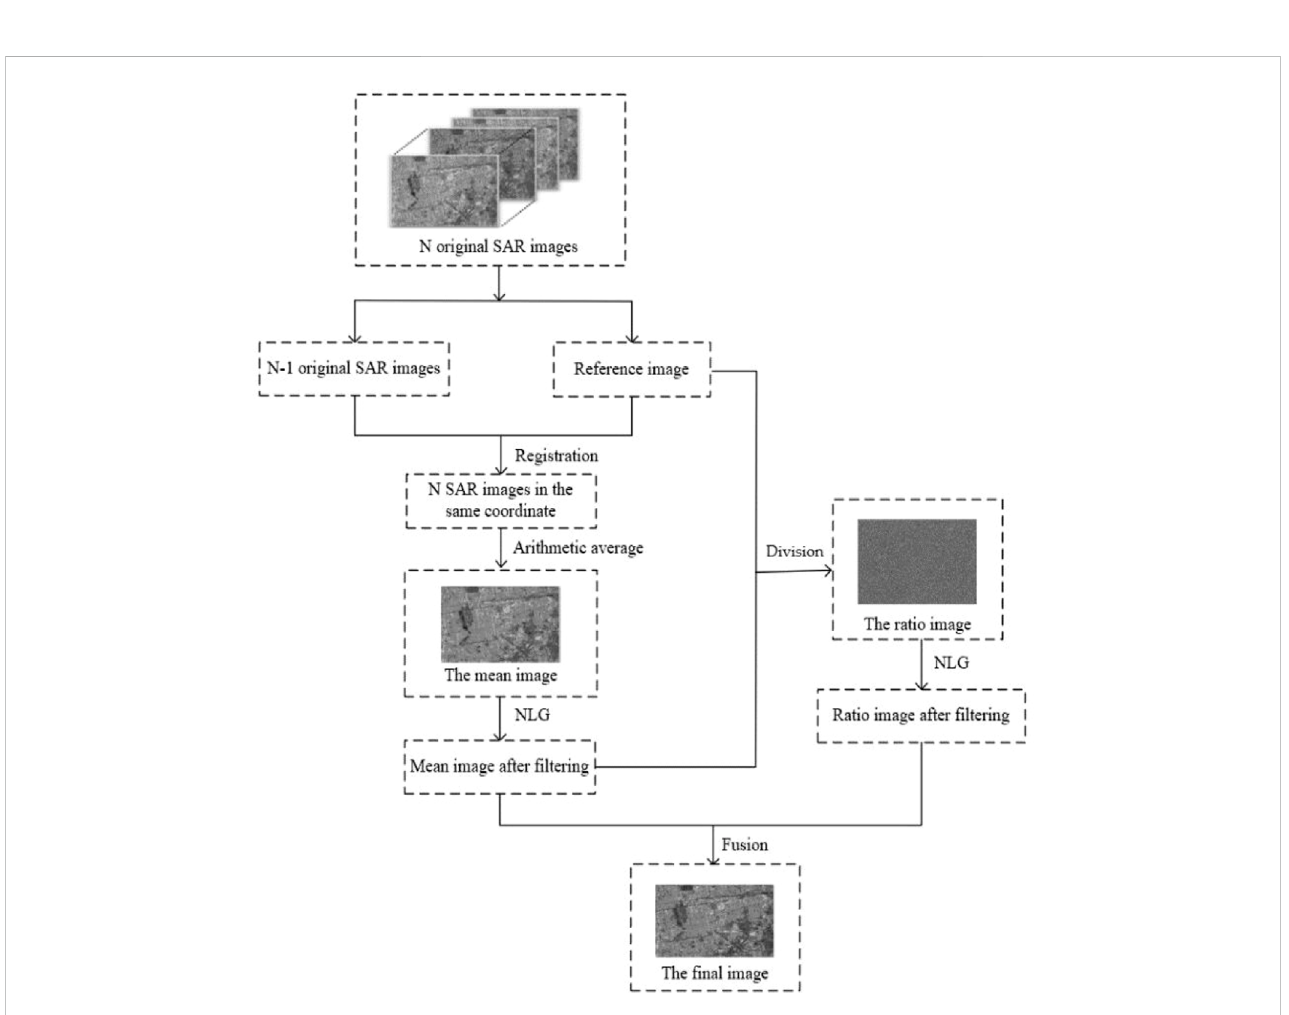
FIGURE 2 Whole fl ow chart of